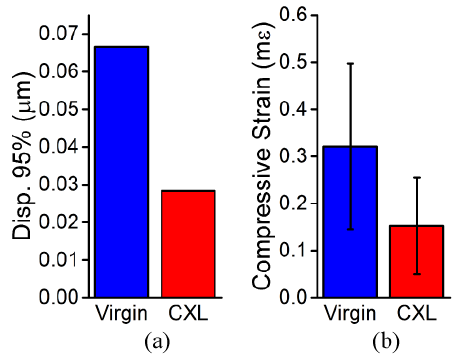
Figure 12. Quantitative analysis of the half-CXL in vivo rabbit cornea (N = 1). ( a ) 95th percentile of the displacement and ( b ) average compressive strain in the dashed regions in Figure 8. Data are presented as the intra-region mean ± standard deviation in ( b ).